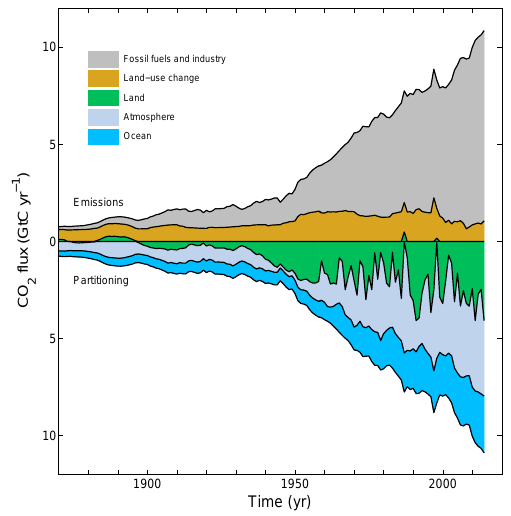
Figure 3. Combined components of the global carbon budget il- lustrated in Fig. 2 as a function of time, for emissions from fossil fuels and industry ( E FF ; grey) and emissions from land-use change ( E LUC ; brown), as well as their partitioning among the atmosphere ( G ATM ; light blue), land ( S LAND ; green), and oceans ( S OCEAN ; dark blue). All time series are in GtCyr − 1 . G ATM and S OCEAN (and by construction also S LAND ) prior to 1959 are based on dif- ferent methods. The primary data sources for fossil fuels and in- dustry are from Boden et al. (2013), with uncertainty of about ± 5% ( ± 1 σ ); land-use-change emissions are from Houghton et al. (2012) with uncertainties of about ± 30%; atmospheric growth rate prior to 1959 is from Joos and Spahni (2008) with uncertainties of about ± 1–1.5GtCdecade − 1 or ± 0.1–0.15GtCyr − 1 (Bruno and Joos, 1997), and from Dlugokencky and Tans (2015) from 1959 with uncertainties of about ± 0.2GtCyr − 1 ; the ocean sink prior to 1959 is from Khatiwala et al. (2013) with uncertainty of about ± 30%, and from this study from 1959 with uncertainties of about ± 0.5GtCyr − 1 ; and the residual land sink is obtained by difference (Eq. 8), resulting in uncertainties of about ± 50% prior to 1959 and ± 0.8GtCyr − 1 after that. See the text for more details of each com- ponent and their